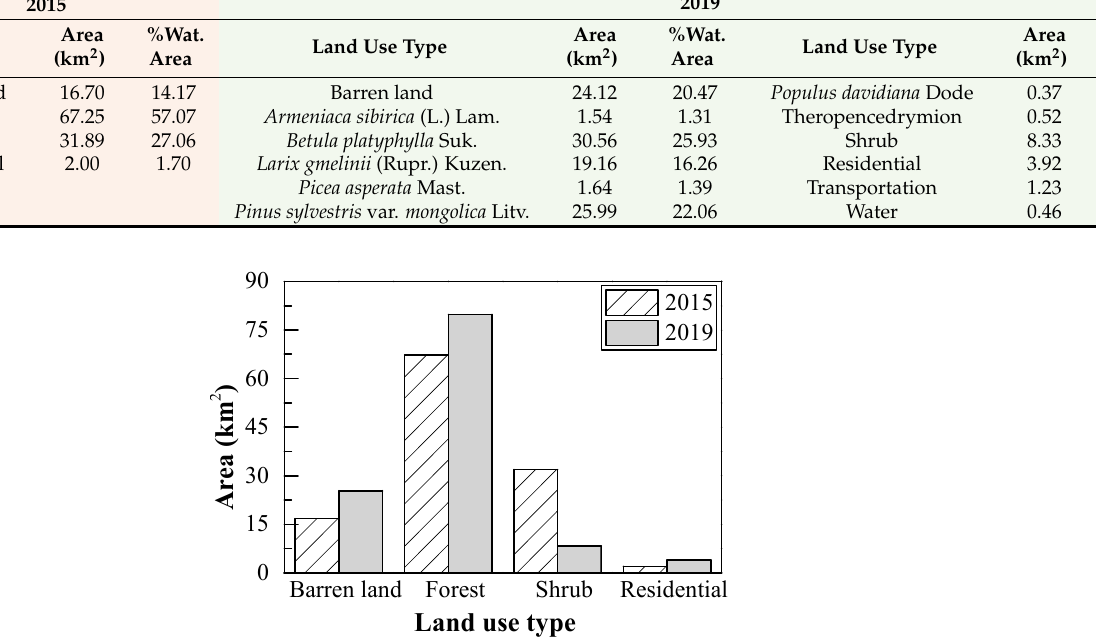
Figure 3. Land use changes of the study area from 2015 to 2019.